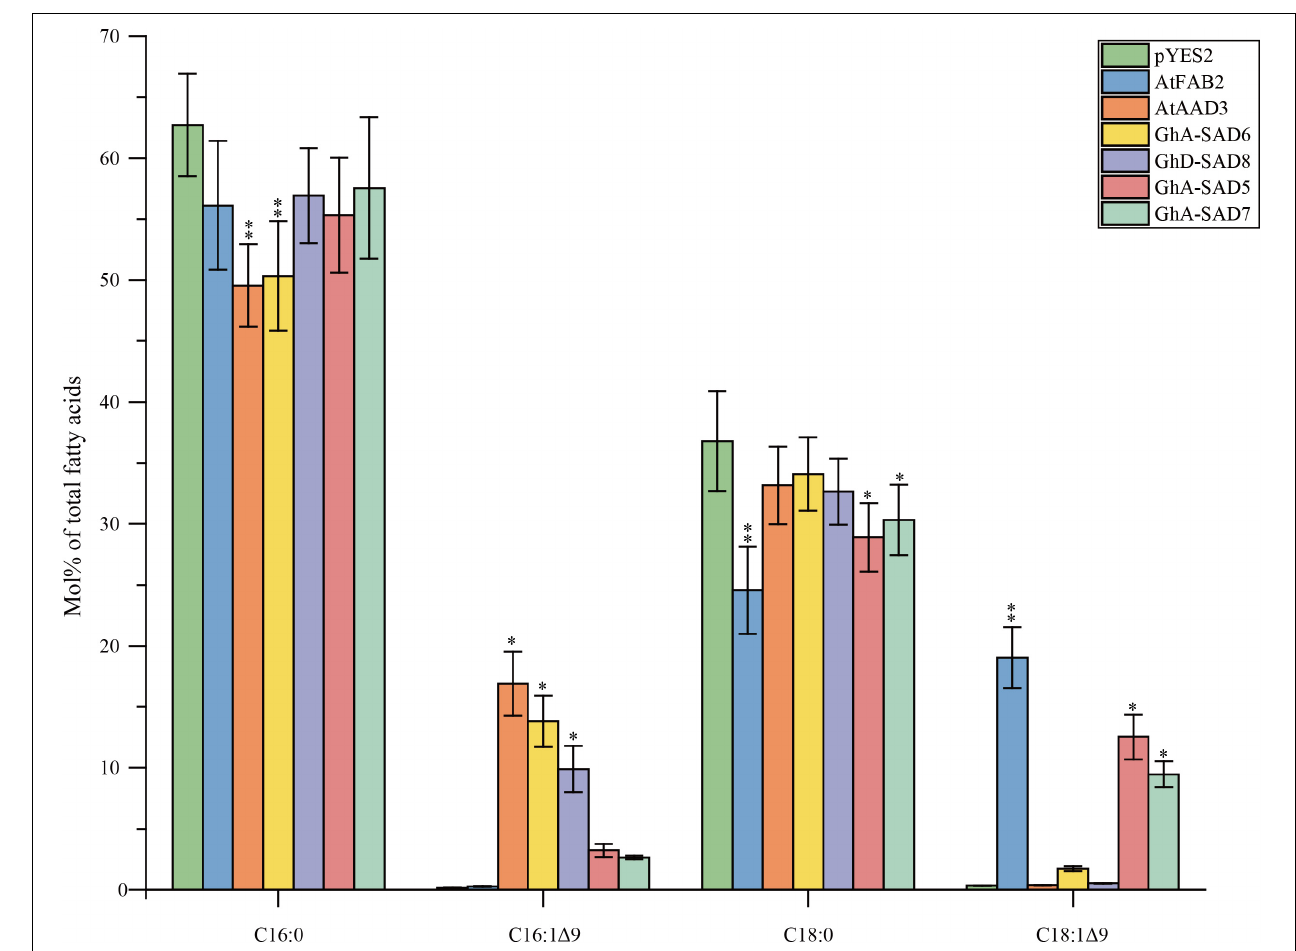
FIGURE 8 | Fatty acid composition in mutant yeasts of BY4389 of expressing GhA-SAD5 , GhA-SAD6 , GhA-SAD7, and GhD-SAD8 , respectively. Fatty acids were analyzed by GC and the data are means of Mol% ± SE with six biological replicates. “ ∗ ” and “ ∗∗ ” represent statistically significant difference values from Wt (or empty) of P < 0.05 and P < 0.01 based on two-tailed Student’s t -tests, respectively. AtFAB2 and AtAAAD3 were used as positive control and empty vector of pYES2 as negative control. Data are showed as mean ± SE ( n =